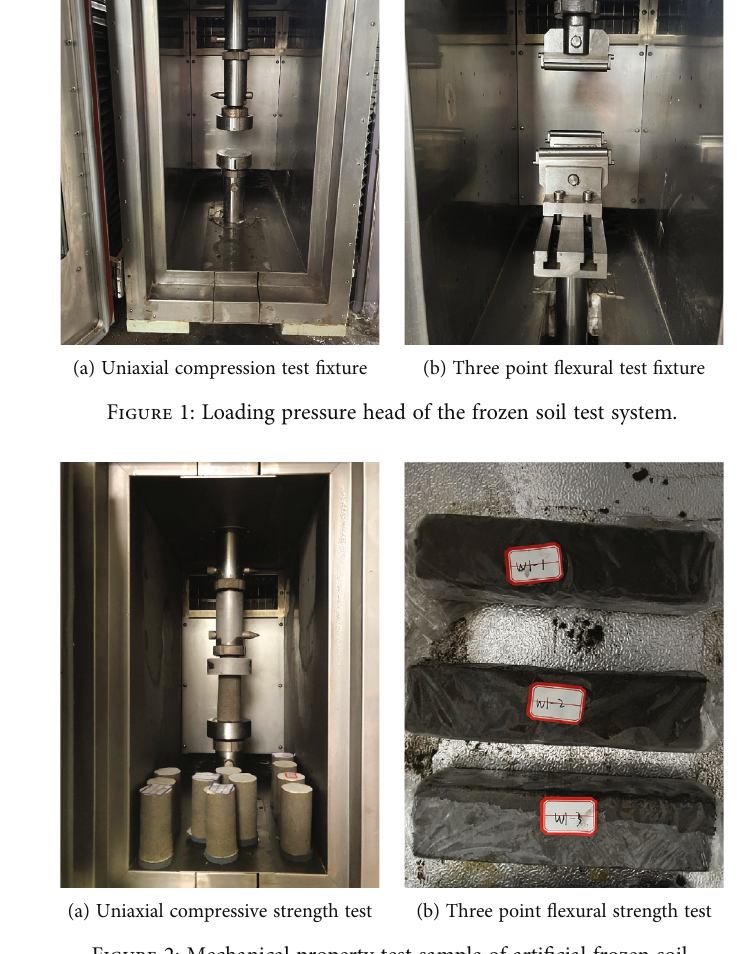
Figure 2: Mechanical property test sample of arti fi cial frozen